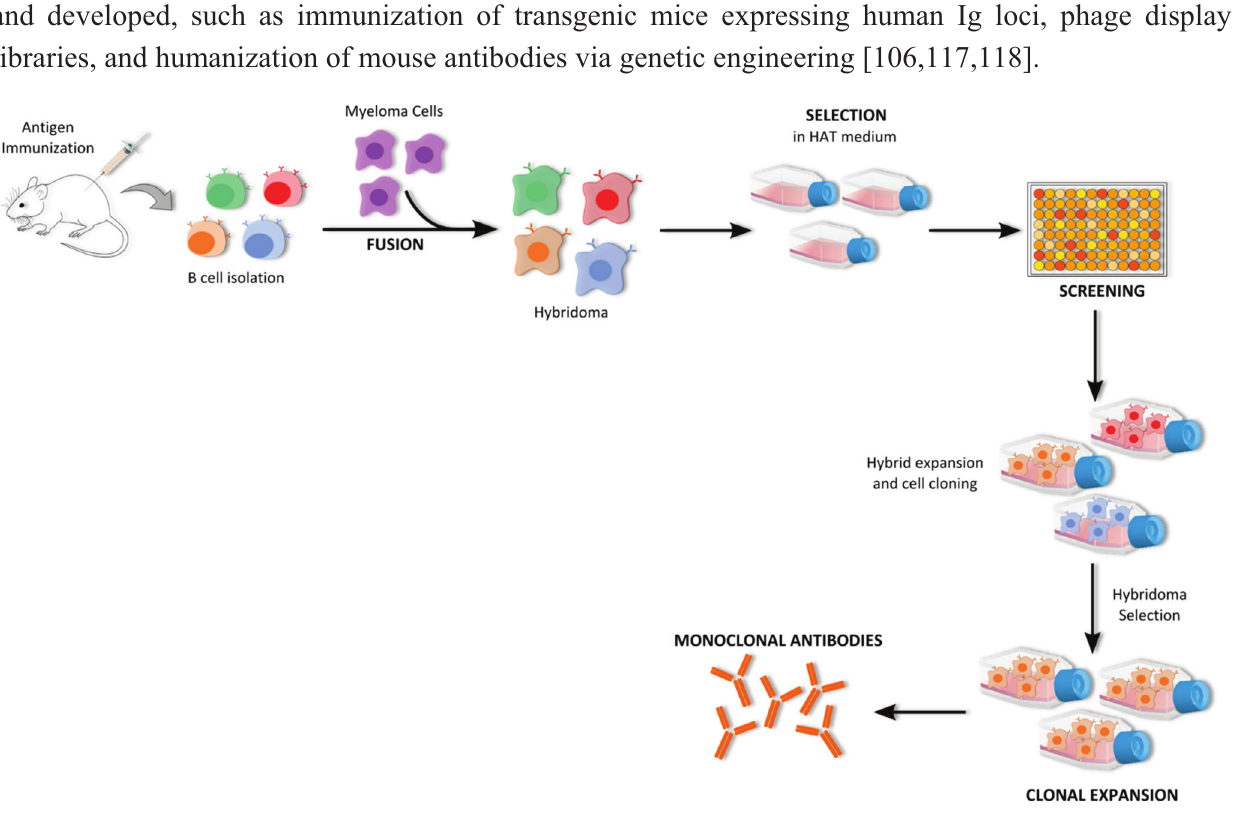
Figure 5. Schematic representation of the hybridoma technology. This technology involves the initial step of mice immunization with desired antigen, followed by the recovery of B cells from mice spleen and consequent fusion with myeloma cells. After that, hybridoma cells are selected in HAT medium and clones are screened according to the reactivity of their supernatants against the antigen. Finally, the selected clones are further cloned and expanded in order to obtain monoclonal antibodies with the desired